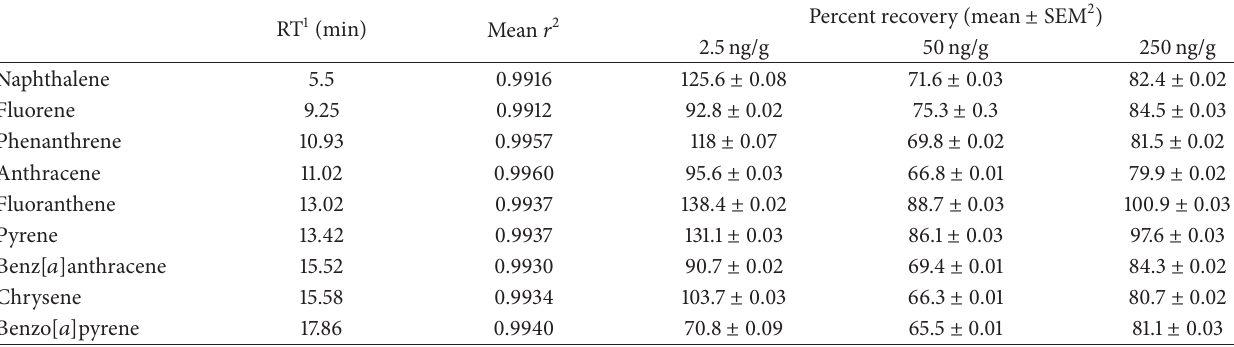
Table 3: Retention time, linear regression, and recovery in oysters.